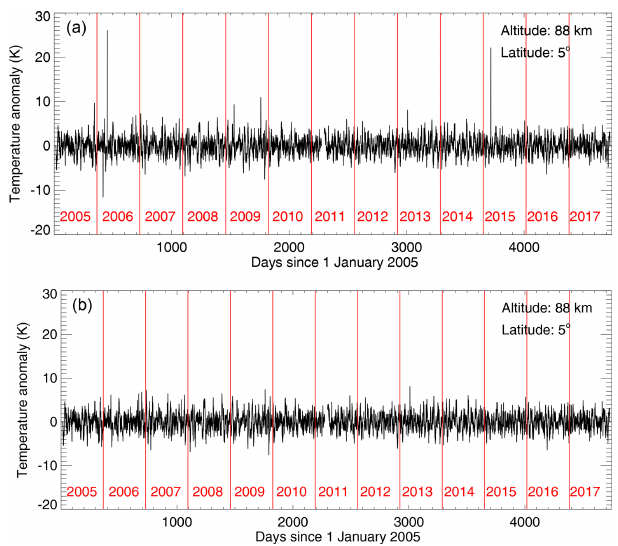
Figure 4. (a) The MLS temperature anomalies generated by sub- tracting a 35d running mean from the time series for an altitude of 88km and a latitude of 5 ◦ N. (b) Similar to (a) except for avoid- ing the abnormal peaks on the days 341, 417, 452, 1532, 1759 and 3717. The plots are based on daily averaged temperature